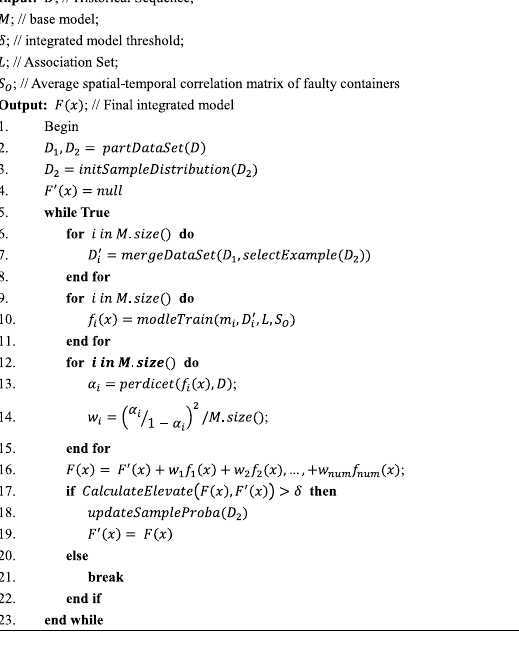
Algorithm 2. Model learning based on dynamic feedback sampling and ensemble learning Container cascade fault detection based on the cascade fault relational